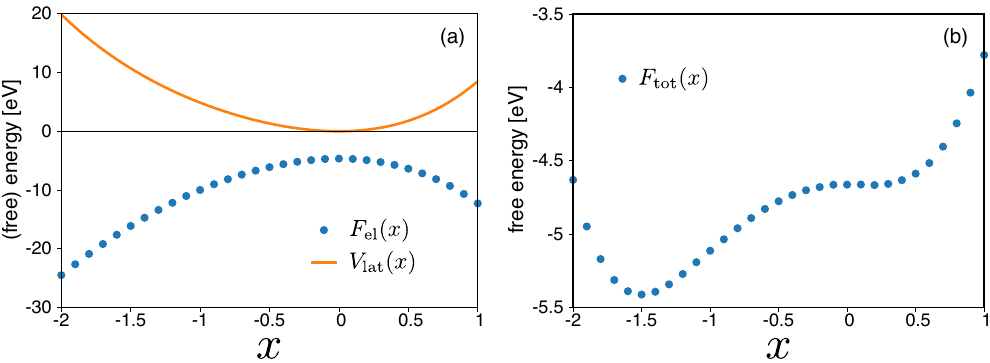
Figure 4. ( a ) electronic free energy F el ( x ) and elastic energy V lat ( x ) accompanied by PLD. These values are per two-hexagram unit cell and F el ( x ) is calculated for U = 3 J = 0.816eV at T = 0K; ( b ) total free energy F el ( x ) + V lat ( x ) calculated from data in panel ( a